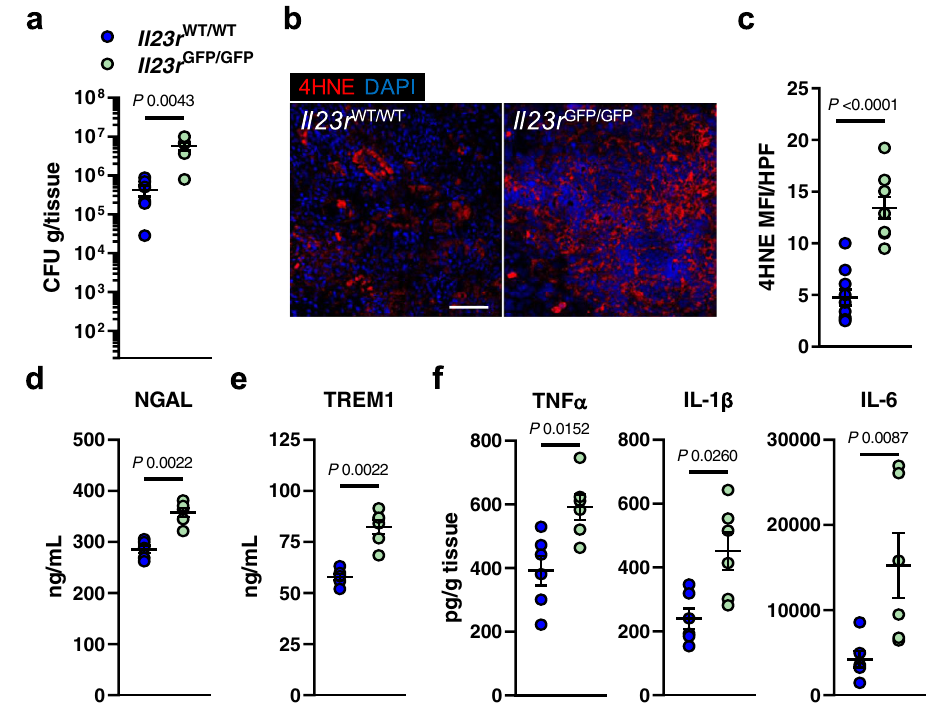
Fig. 7 | IL-23 receptorsignaling decreases ferroptosisandin fl ammationduring disseminated candidiasis. a Renal fungal burden after 3 days of infection. N =6; combined data of two independent experiments. Two-tailed Mann – Whitney Test. b , c Lipid peroxidation (4HNE) in infected kidneys after 3 days of infection. 4HNE shown in red, tissue stained with DAPI (blue). Scale bar 100 μ m. Quanti fi cation of mean fl uorescence intensity (MFI) per high-power fi eld (HPF). N =10 immuno- fl uorescence pictures for Il23r WT/WT and N =9 for Il23r GFP/GFP ; combined data of two